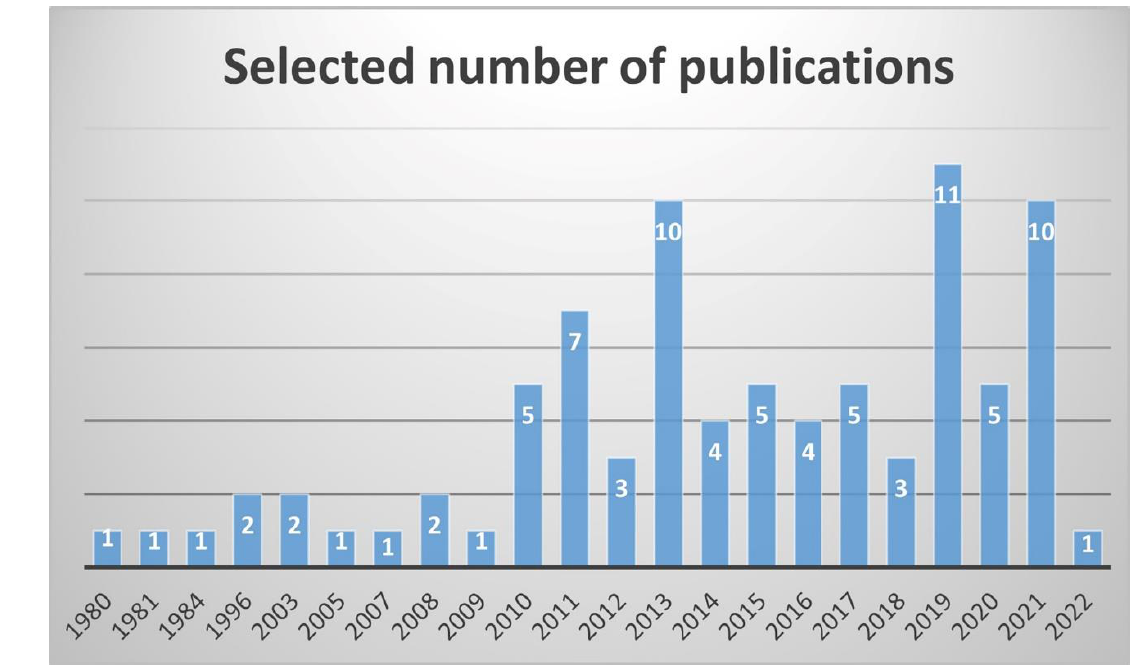
Figure 3. Number of selected Cynometra scientific publications by year. Table 2. Ethnomedicinal uses of the genus Cynometra